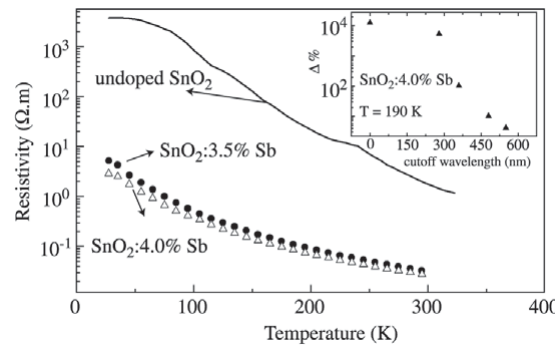
Figure 5. Resistivity as function of temperature for SnO prepared by PII, with 30 dips and 3 different Sb compositions. Inset - relative increase in the conductivity as function of illumina- tion using filters with several different cut-off wavelengths, meas- ured at 190